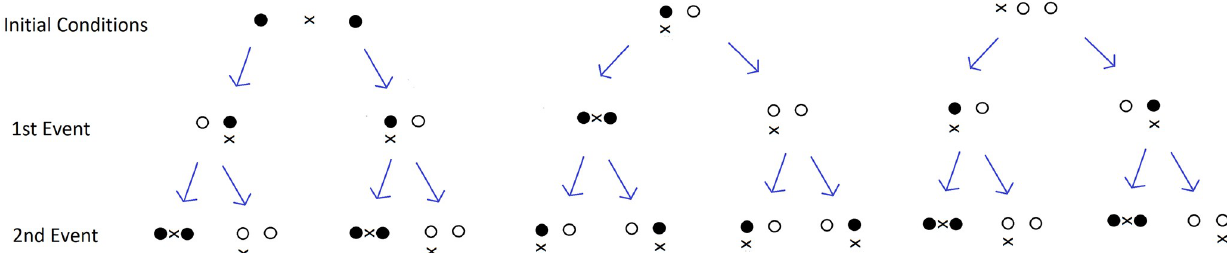
Fig 2. Visualization of the centroid model (n = 2). The left column shows the three possible initial conditions: No attached FAs, one attached FA and 2 attached FAs (in any configuration). The arrows point to possible transitions. Distance is measured vertically. The open dots indicate a detached adhesion site and a black dot represents an attached adhesion site. An “x” indicates the centroid. When the centroid is in the same position as a dot, then it is indicated to the right of the dot.